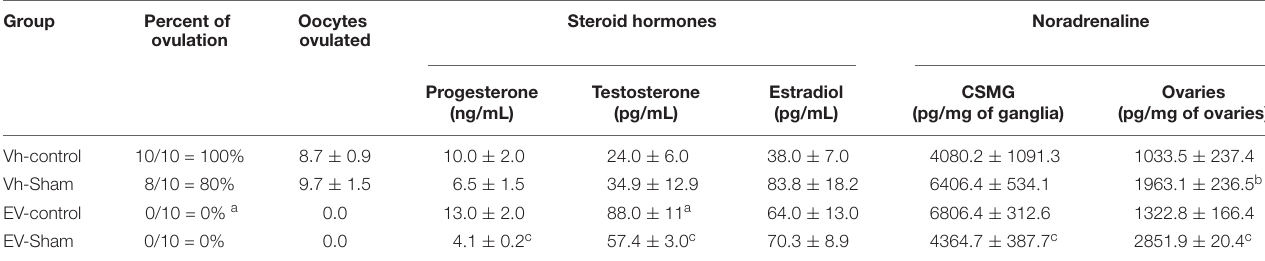
TABLE 1 | Percentage of ovulating animals and mean ± SEM number of total oocytes ovulated; progesterone, testosterone, estradiol serum concentrations; and noradrenaline concentration in celiac superior mesenteric ganglia (CSMG) and ovaries of rats treated with vehicle (Vh) or estradiol valerate (EV) at day 10 of life, without surgery (control) or with sham surgery (sham) at day 76 of life. Group Percent of Oocytes Steroid hormones Noradrenaline ovulation ovulated Progesterone Testosterone Estradiol CSMG Ovaries (ng/mL) (pg/mL) (pg/mL) (pg/mg of ganglia) (pg/mg of ovaries)